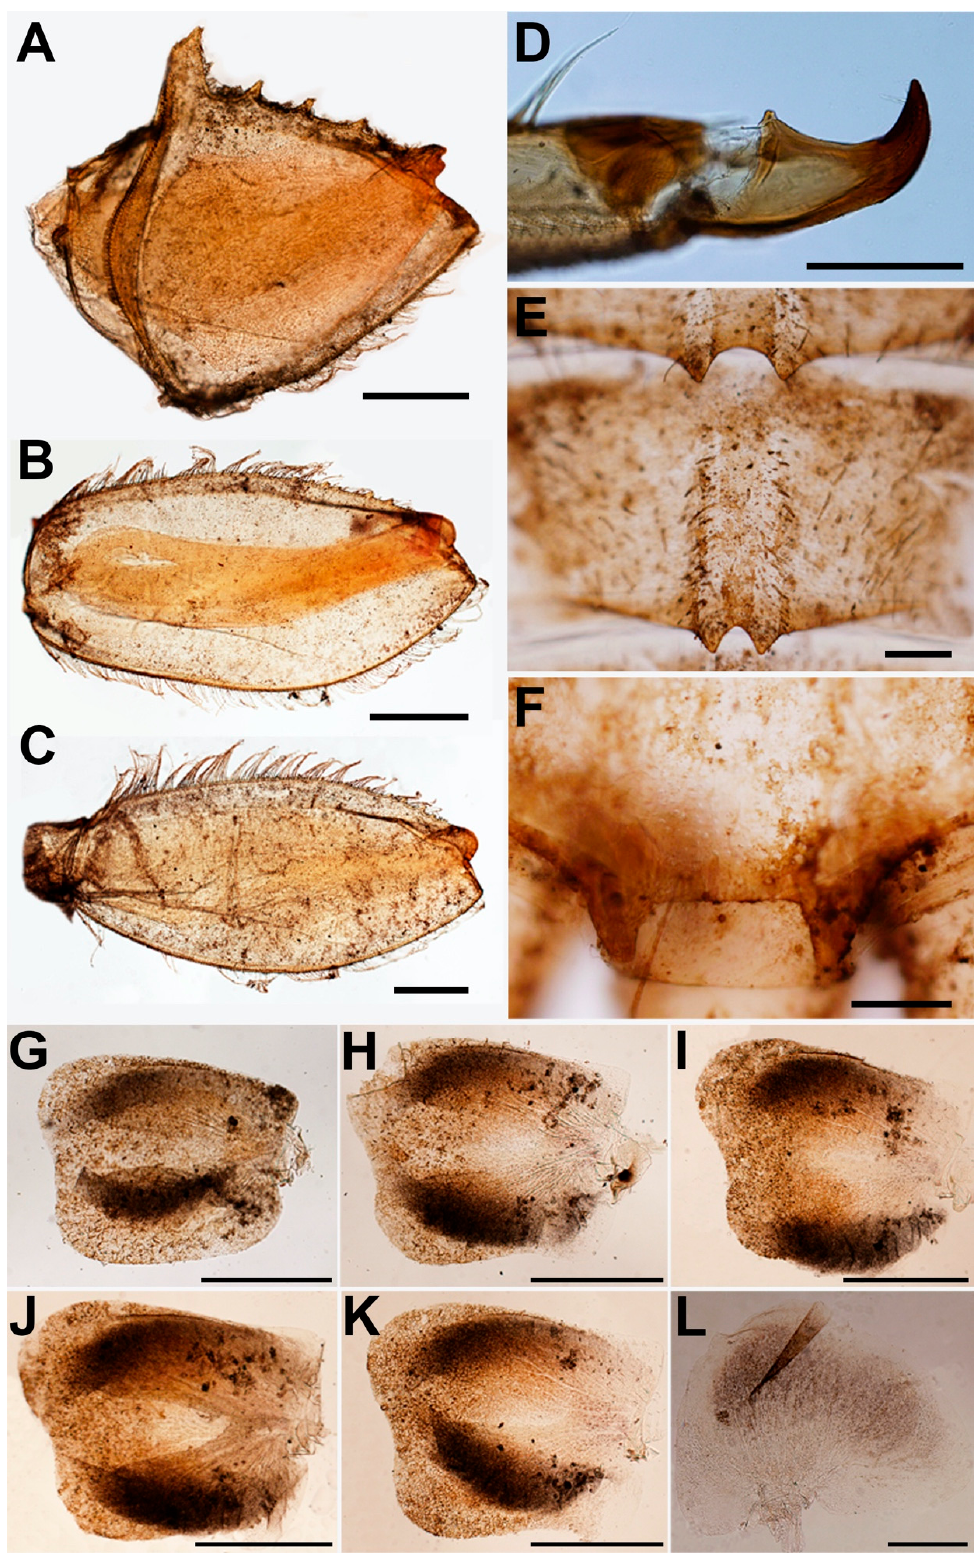
Figure 3. Vietnamella nanensis sp. n. ( A ) forefemur; ( B) midfemur; ( C ) hindfemur; ( D ) foretarsal claw; ( E ) abdominal terga VI–VII; ( F ) abdominal tergum X; ( G ) gill II; ( H ) gill III; ( I ) gill IV; ( J ) gill V; ( K ) gill VI; ( L ) gill VII. Scale bars: 0.5 mm ( A–C , E–K ), 0.2 mm ( D , L ).